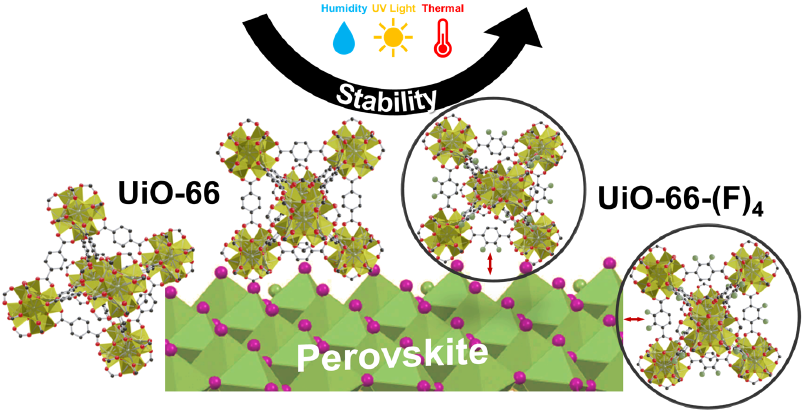
Figure 5. Schematic of the interaction of perovskite/UiO-66 and perovskite/UiO-66-(F) 4 . We next analyzed the UV-Vis absorption of these samples before and after aging.